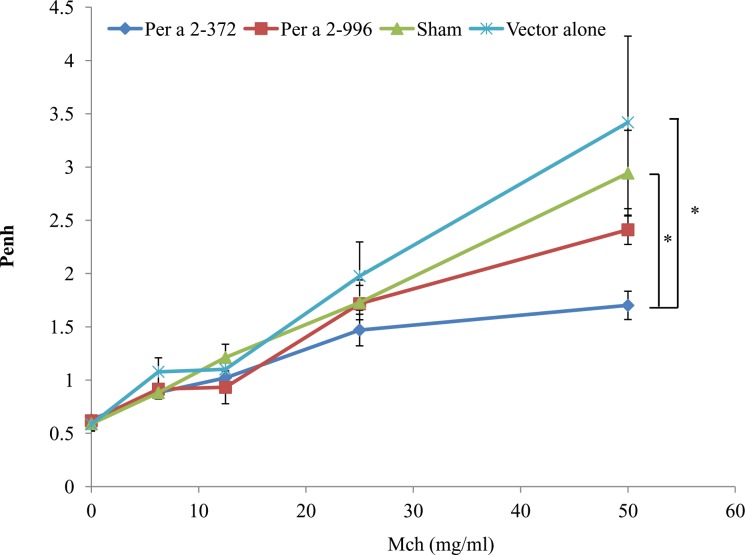
Effect of plant vaccine on airway hyperresponsiveness in rPer a 2-challenged mice.Mean enhanced pause (Penh) values were evaluated at indicated doses of methacholine (Mch) in the four groups (n = 5–6 per group). *p<0.05 by one-way analysis of variance with the Bonferroni multiple range test.